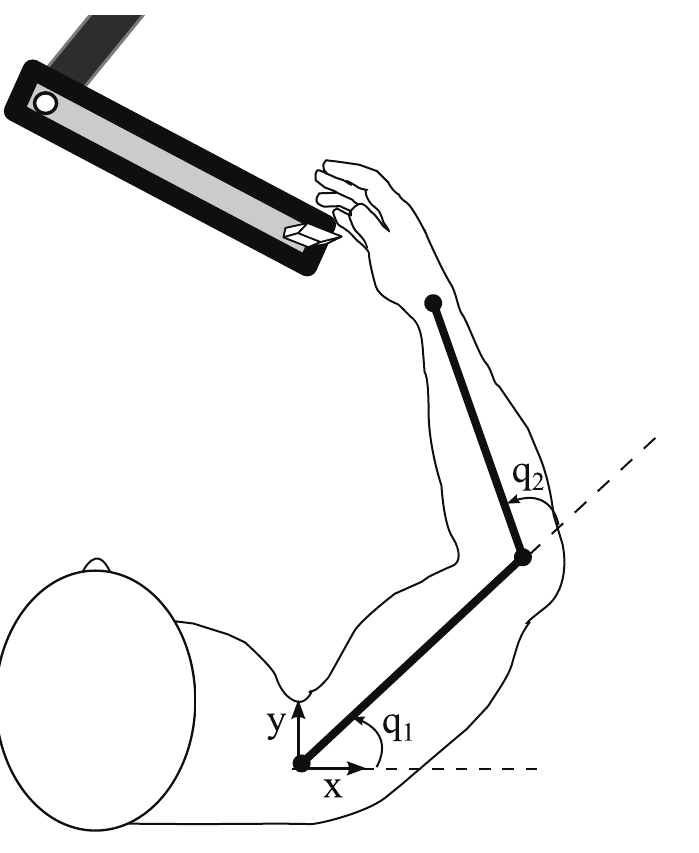
Fig 5. Schematic of a planar reaching experiment. The arm is modeled with a 2 degree-of-freedom (DOF) system involving the shoulder and elbow joints.